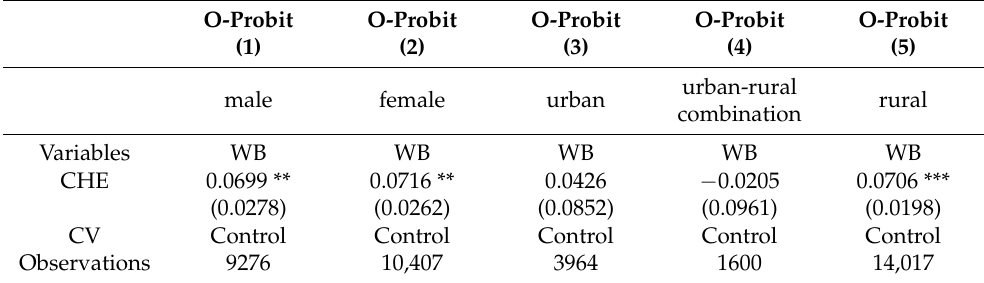
Table 6. The results of heterogeneity